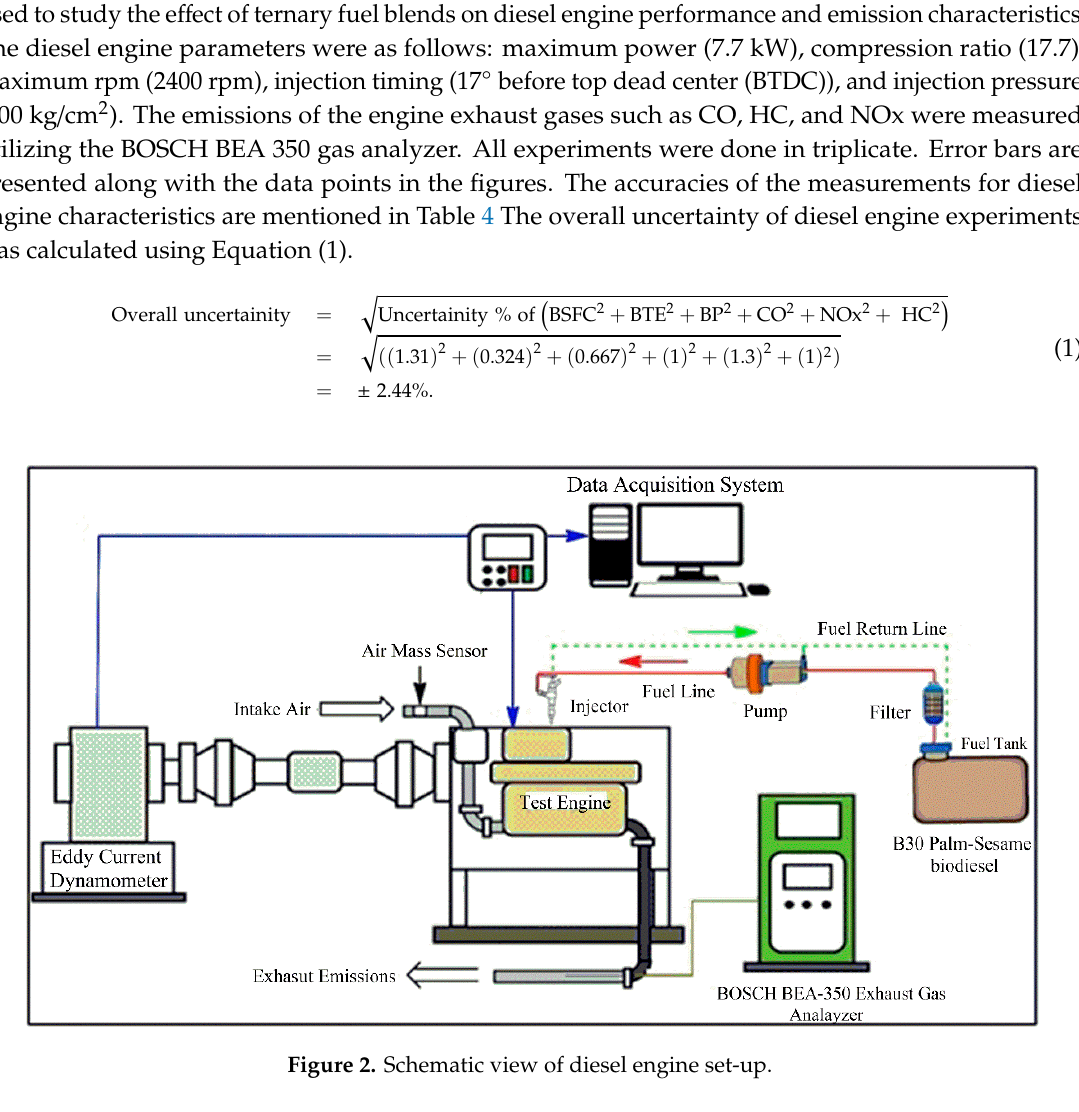
Figure 3. Schematic view of HFRR test rig.